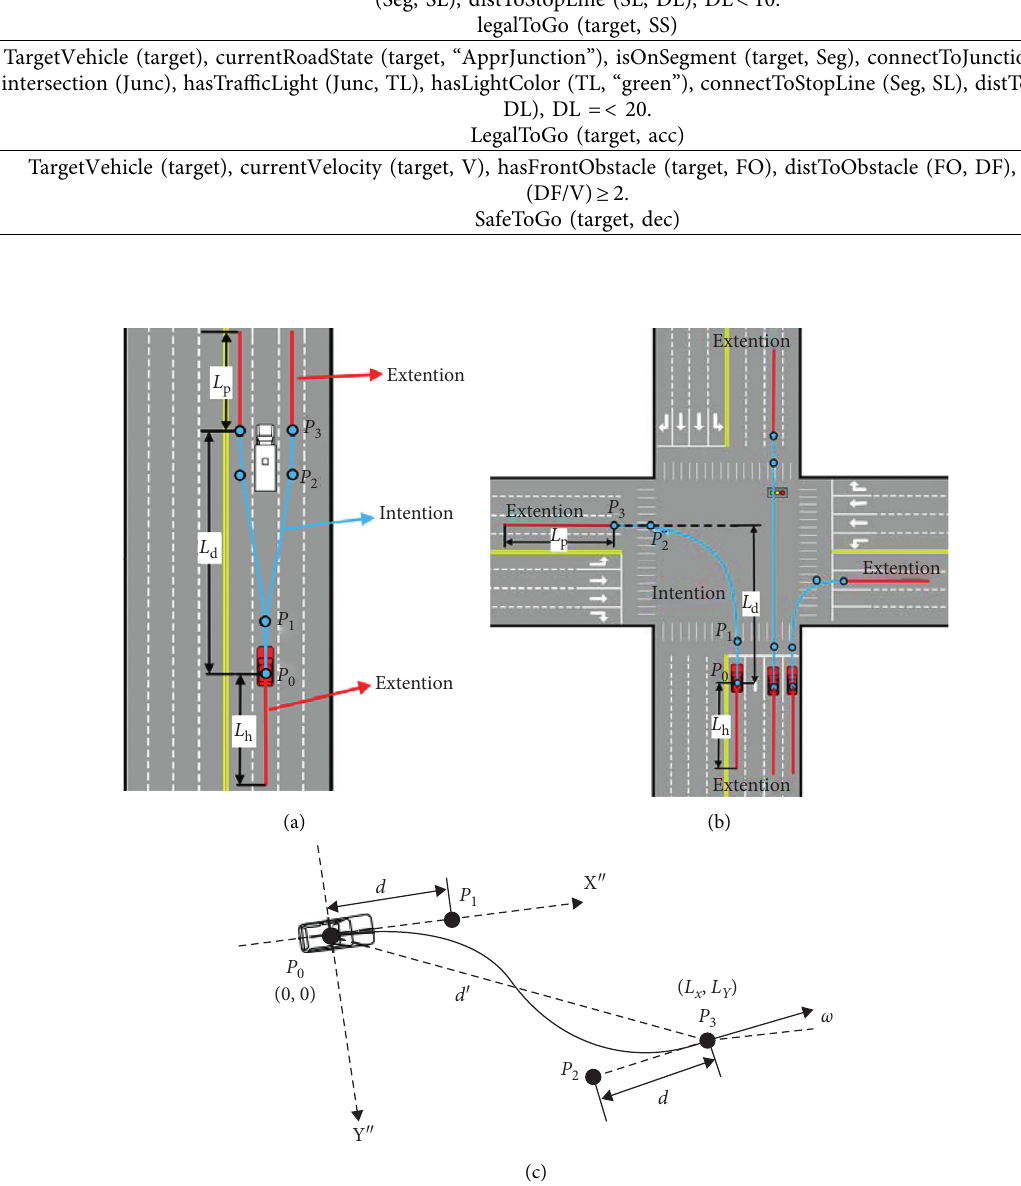
Figure 8: Schematic diagram of prediction reference baseline fitting: (a) lane-changing scene; (b) intersection turning scene; (c) the cubic Bezier curves.